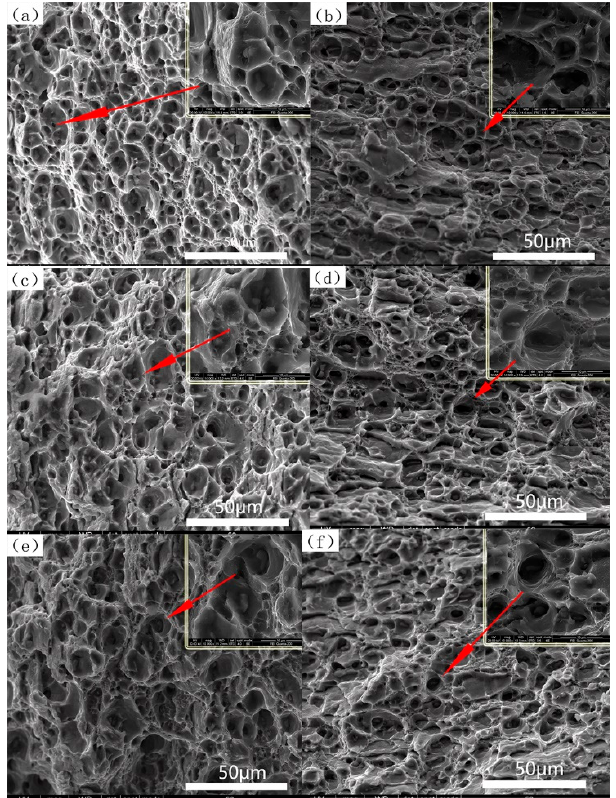
Figure 9. Fracture morphology of the alloys treated with two different aging. ( a , c , e ) delayed aging specimens; ( b , d , f ) pre-aging specimens. ( a , b ) 1 h; ( c , d ) 12 h; ( e , f ) 24 h.